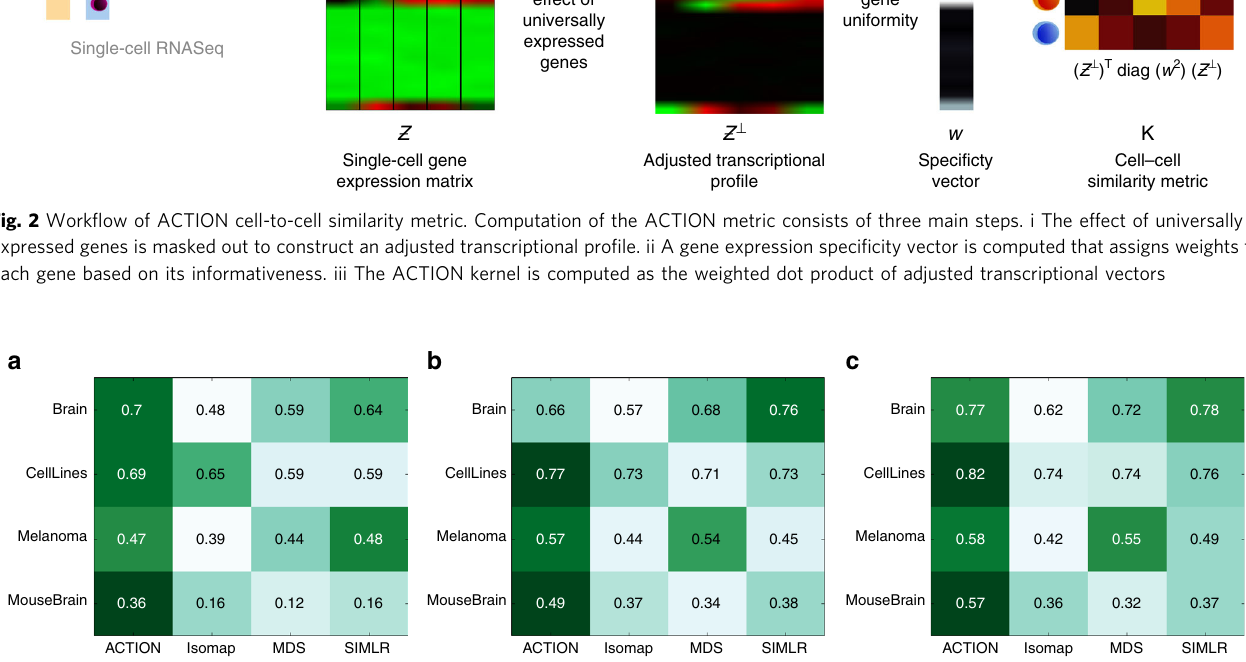
Fig. 3 Performance of ACTION Similarity Metric. Various extrinsic measures of clustering quality for different cell similarity scores. a Adjusted Rand Index (ARI), b F-score, and c Normalized Mutual Information (NMI). All of these measures are upper-bounded by one with larger values indicating better results. The results in the table are the mean value over 100 individual runs of kernel k-means clustering with different initializations. The ACTION metric has no tunable parameters. For the other methods, we tested a range of parameters and report the best results. For each dataset, the corresponding row has been color-coded such that the darker green indicates better performance. Except for the Brain dataset, ACTION is either the best, or jointly the best. For Brain, the SIMLR metric is slightly better in an aggregation over all three